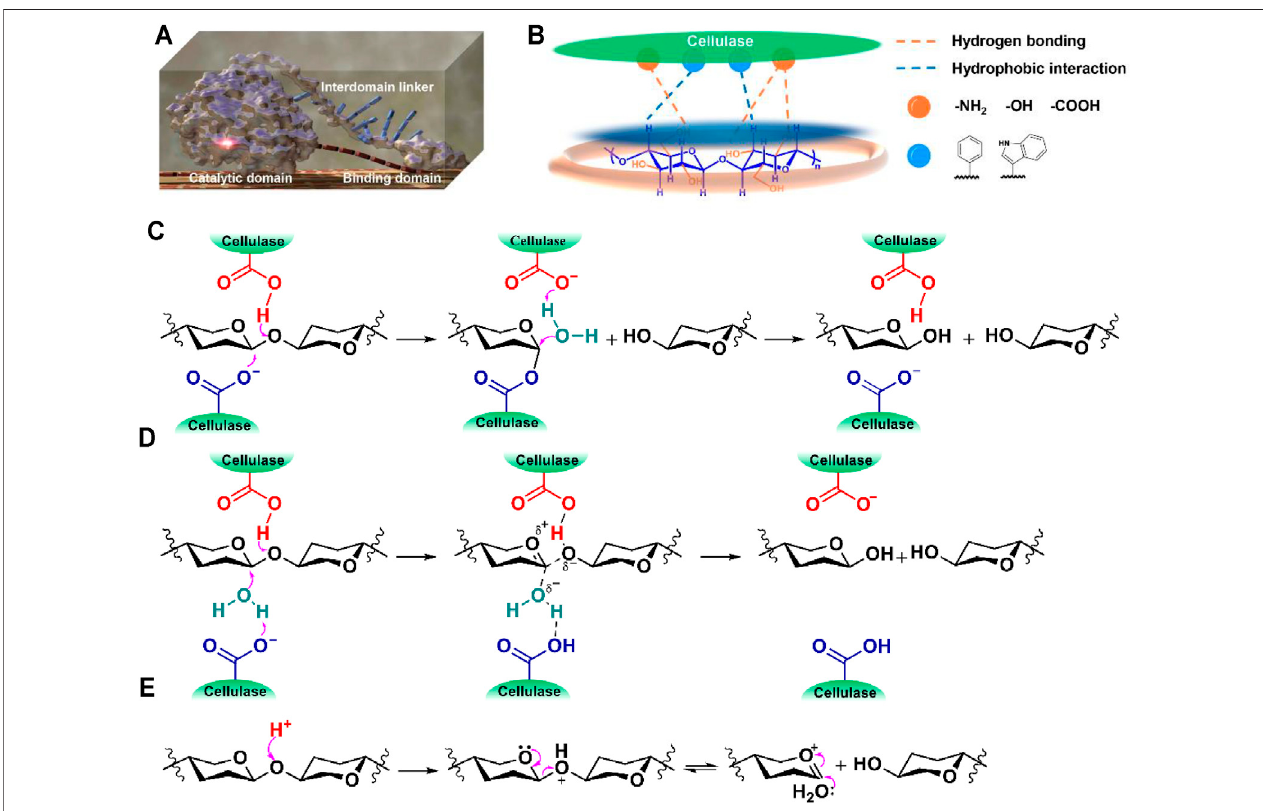
FIGURE 1 | (A) A modeling image of cellulase, (B) cellulase-cellulose binding via hydrogen bonding (orange) and hydrophobic interactions (blue), catalytic hydrolysis of cellulose by cellulase in (C) a retaining or (D) an inverting mechanism, and (E) a proposed mechanism of mineral acid-catalyzed cellulose hydrolysis (substituted groups are omitted for better